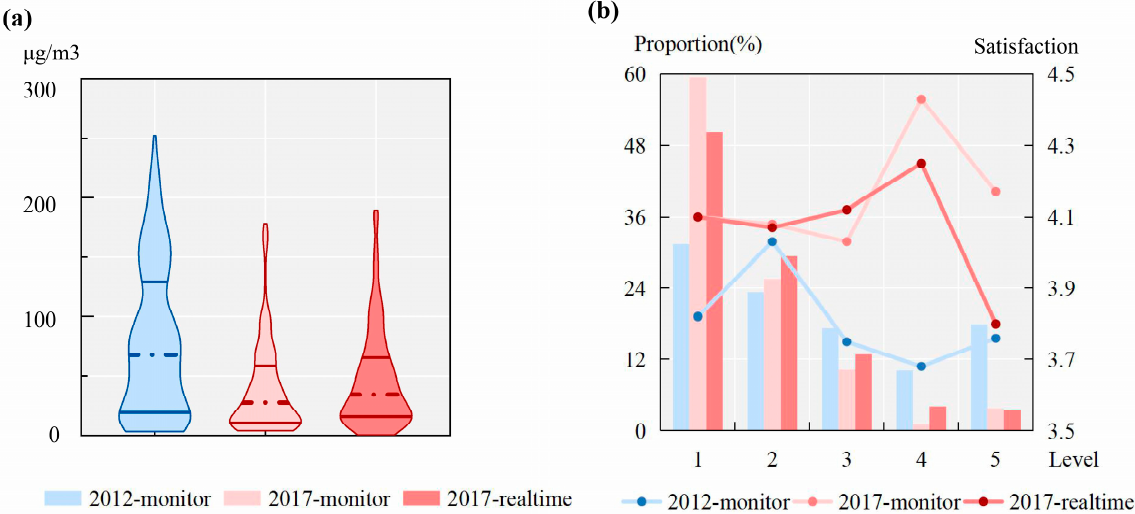
Figure 3. ( a ) Violin plot of objective air pollution and ( b ) average satisfaction at different pollution levels.